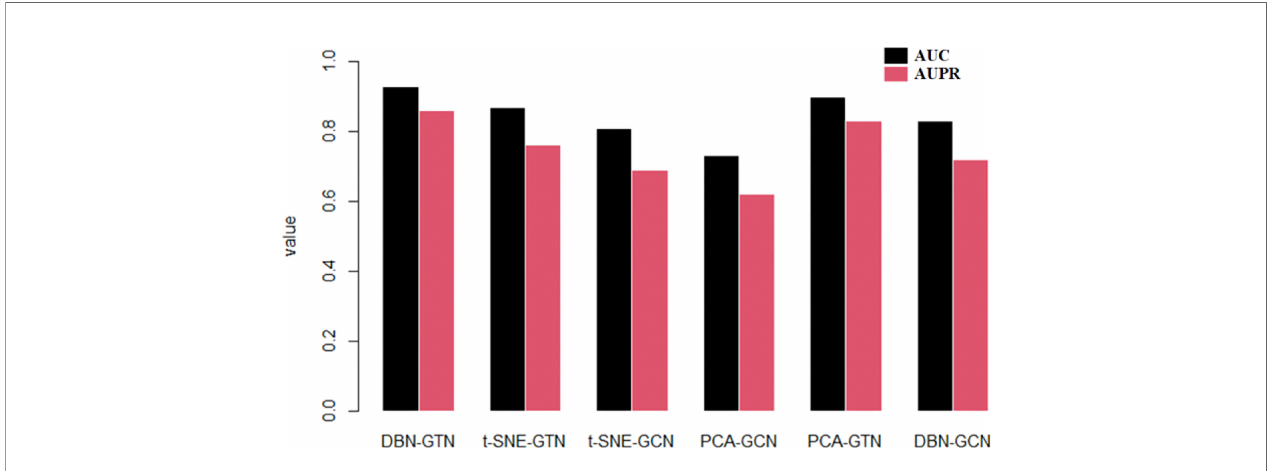
FIGURE 2 | AUC and AUPR of DBN-GTN and